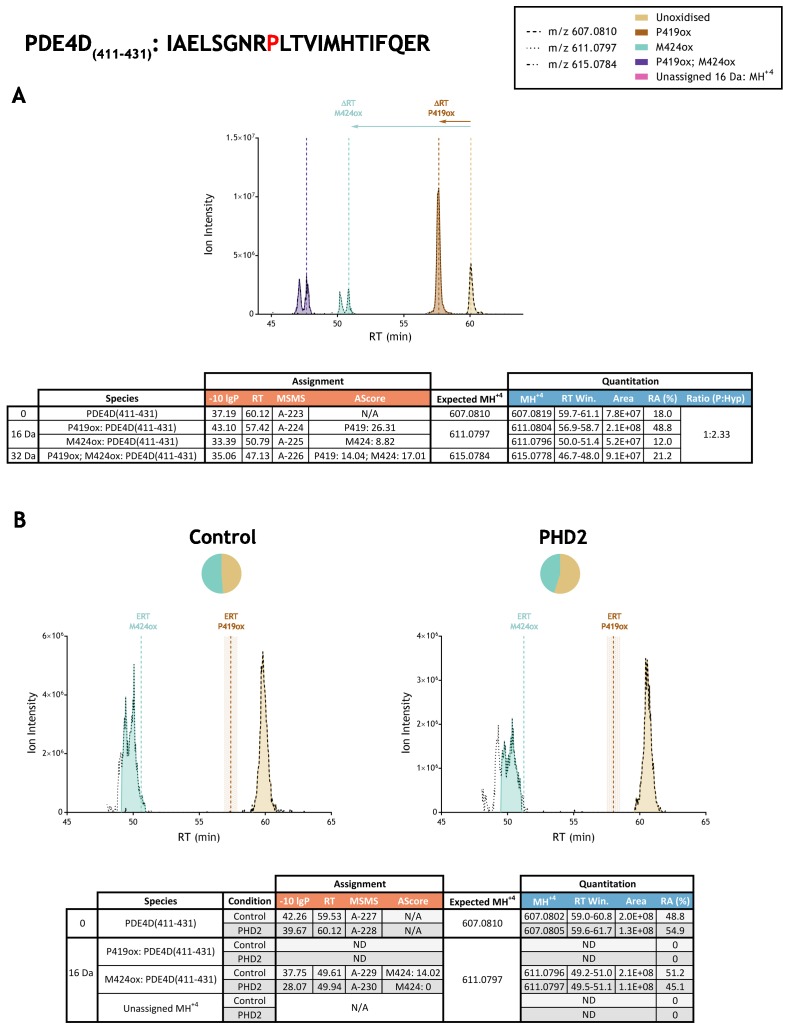
Quantitation of peptide oxidation on PDE4D(411-431) following reaction of full-length phosphodiesterase 4D (isoform 6) with recombinant PHD2.XIC data presented in (A) shows ion intensity and retention time (RT) characteristics of equimolar synthetic peptide standards for unoxidised and P419ox forms of the PDE4D(411-431) peptide. MSMS assigned species are coloured (see inset) and include non-enzymatic methionine oxidation (M424ox; turquoise) that elutes as a split peak; vertical dashed lines define peak maxima used to derive ΔRT values for P419ox and M424ox. Panel (B) shows comparable XIC data for protease-digested IVTT substrate under control (left) or PHD2-reacted (right) conditions. Peaks corresponding to unoxidised and M424ox forms of PDE4D(411-431) were assigned by MSMS (see inset for colour code); P419ox was not detected. Estimated RT (ERT) values for oxidised peptides, derived from (A), are indicated by dashed vertical lines, shading applied to ERT P419ox corresponds to a 1 min RT window. Unassigned ions of compatible mass over charge for hydroxylation were not observed across the elution window. Note, unrelated ions were detected in the XIC of m/z 611.0797; turquoise shading corresponds to the monoisotopic MSMS-assigned M424ox species. Quantitative data for observed species are presented as pie charts with XIC data. Assignment and quantitation data are tabulated below each panel, table headers are as follows: (−10lgP) significance score of leading assignment at given (RT) with ambiguity score (AScore) for PTM localisation and reference to primary MSMS data in Supplementary file 1. Quantitative data reports ion counts (Area) of observed masses (MH+3) integrated over time (RT Win.), expressed as relative abundance (RA). Data on detection efficiency for synthetic peptides (Panel A, P: Hyp) is an aggregated ratio of prolyl (P) to hydroxyprolyl (Hyp) containing species.